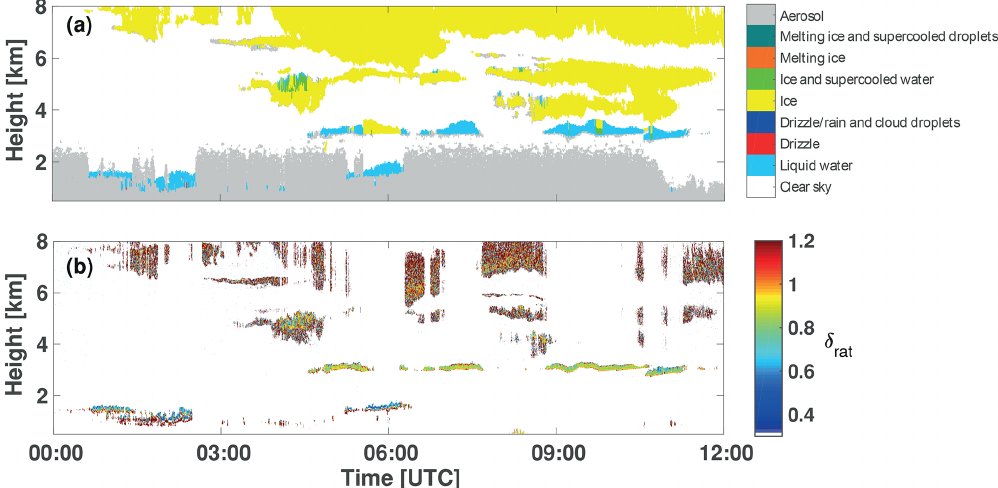
Figure 3. (a) Cloudnet target classification of the cloud layers shown in Fig. 2 and (b) ratio δ rat = δ in /δ out measured with the dual-FOV polarization lidar Polly (FOV in = 1mrad, FOV out =